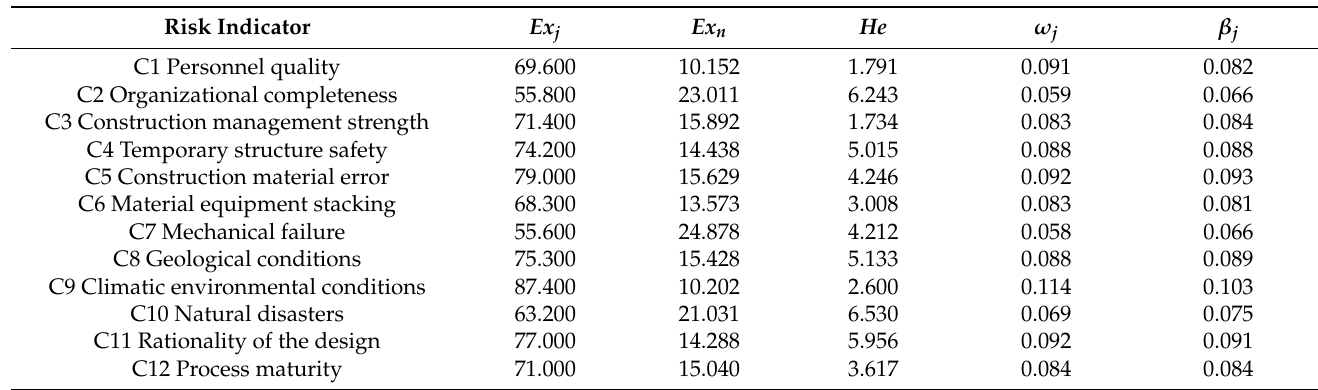
Table 3. Objective weighting of risk indicators.